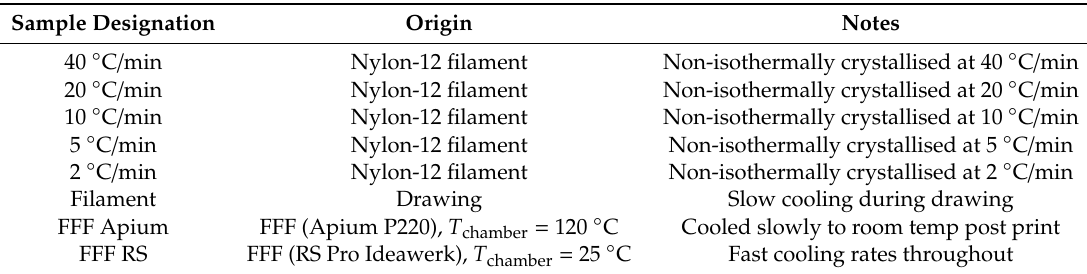
Table 1. List of samples tested by